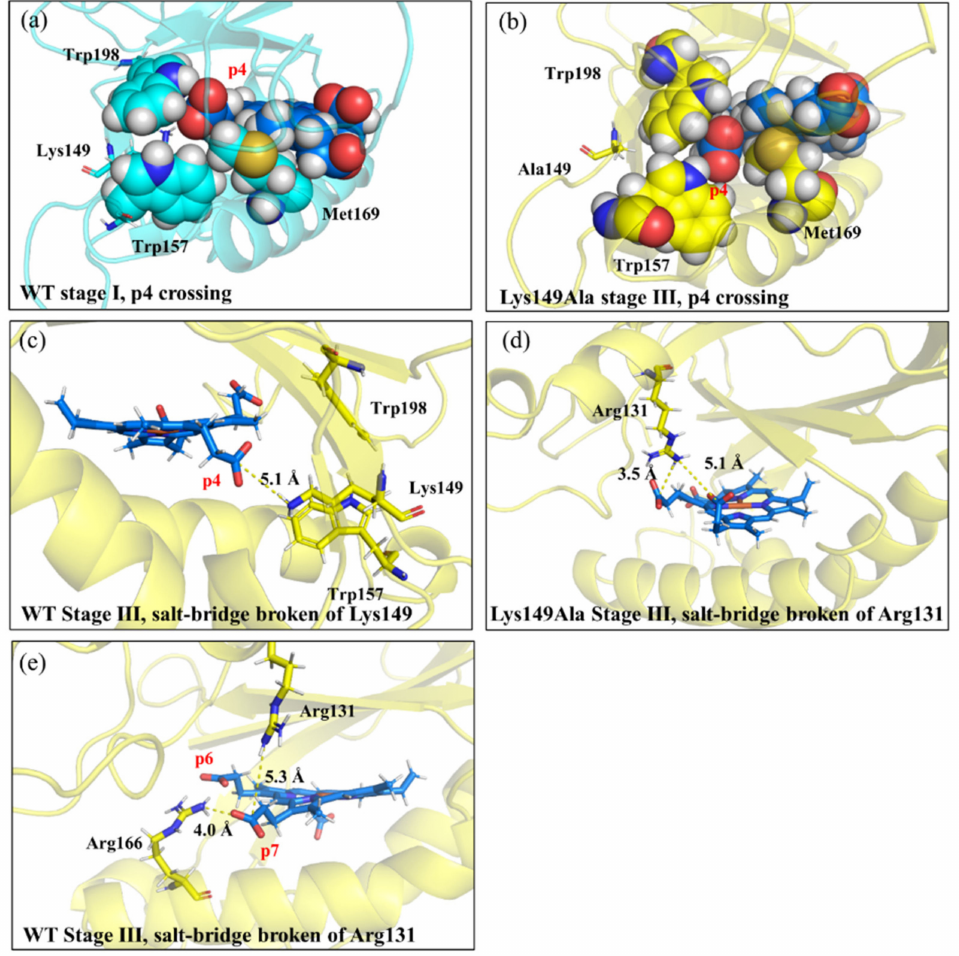
Figure 7. Representative active site structures at different stages of the harderoheme rotation process: ( a ) WT, stage I, p4 crossing through the Trp157 and Trp198 residues; ( b ) Lys149Ala, stage III, p4 crossing through the Trp157 and Trp198 residues; ( c ) WT, stage III, the salt bridge interruption between p4 and Lys149; ( d ) Lys149Ala, stage III, the salt bridge interruption between p4 and Arg131 and ( e ) WT, stage III, the salt bridge interruption between p7 and